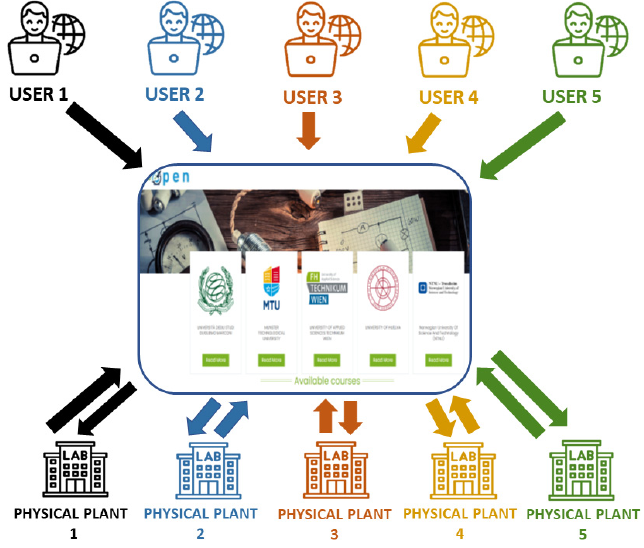
Table 3. Supercapacitor power bank s ystem specifications.